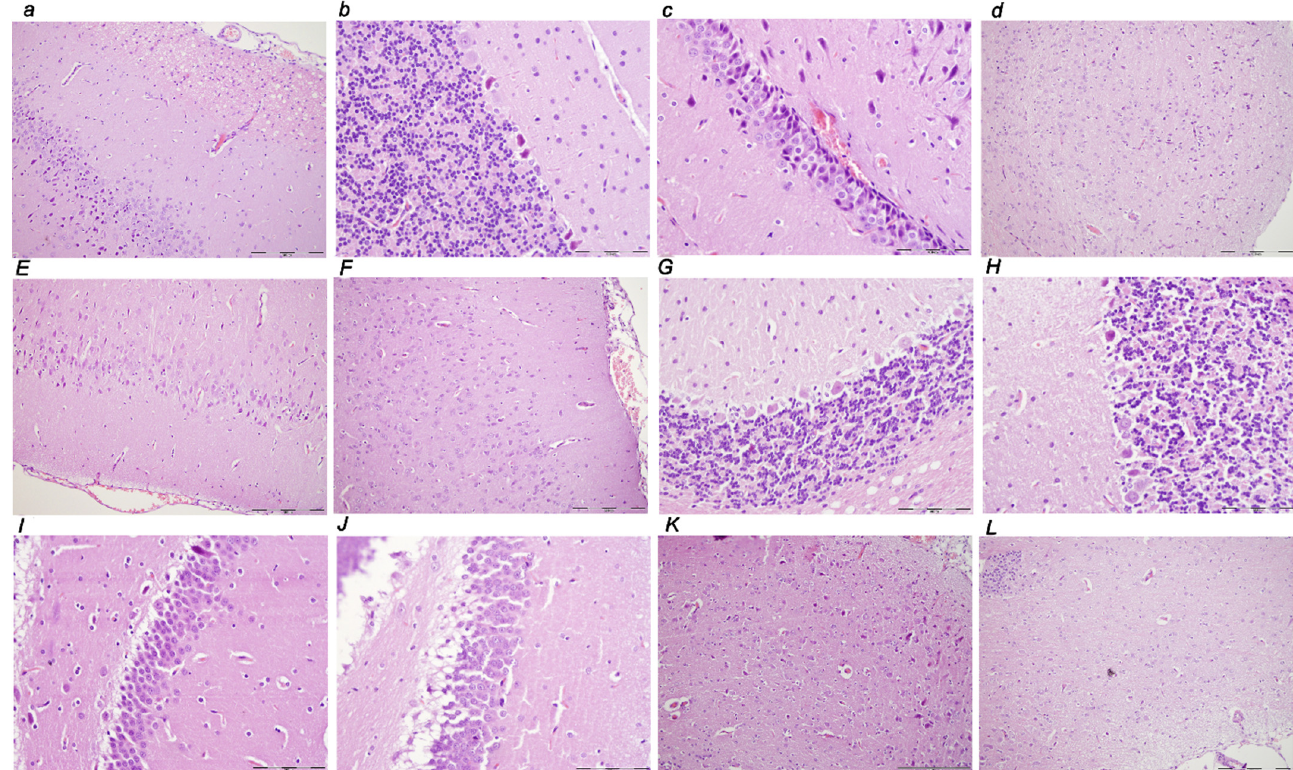
Figure 16. Neuropathological changes of cerebral area ( a , E , F ), cerebellar cortex ( b , G , H ), hyothalamus ( c , I , J ), and hippocampus ( d , K , L ) (HE staining; magnification 400×; scale bar 50 μ m) in rats with obstructed bile duct ( a – L ) at the end of the ligation time period of 24 h. Controls. Necrosis of superficial neocortical areas of the cerebral tissue in control rats following karyopyknotic cells in the cerebral cortex ( a ), moderate karyopyknosis and degeneration of Purkinje cells of the cerebellar cortex ( b ), marked congestion and edema with marked karyopyknosis of pyramidal cells of the hippocampus ( c ), marked congestion and edema with marked karyopyknosis of pyramidal cells of the hypothalamus ( d ) at 24 h ligation time. BPC 157. No necrosis and only few karyopyknotic cells in cerebral cortex was found with early regimen 0–24 h ( E ) and delayed regimen at 5 h–24 h ( F ). No karyopyknotic cells in cerebellar cortex with early regimen 0–24 h ( G ). Only few karyopyknotic and degenerated Purkinje cells of the cerebellar cortex was found in the delayed regimen at 5 h–24 h ( H ). Only rare karyopyknotic cells in hippocampal area with early regimen 0–24 h ( I ) and delayed regimen at 5 h–24 h ( J ). Only rare karyopyknotic cells in hypothalamic area with early regimen 0–24 h ( K ) and delayed regimen at 5 h–24 h ( L ).